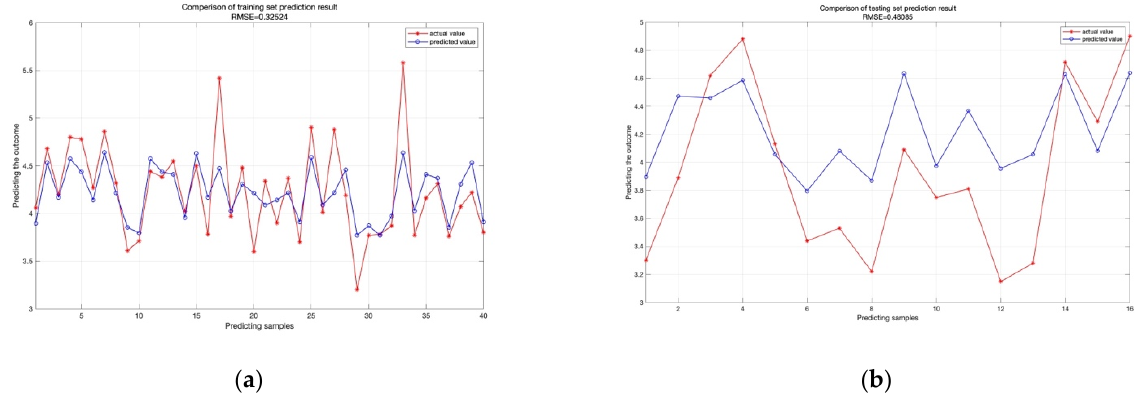
Figure 15. It is the comparative results of surface bonding strength prediction using the random forest algorithm when the tree species is Scotch pine, ( a ) for the training set and ( b ) for the test set.